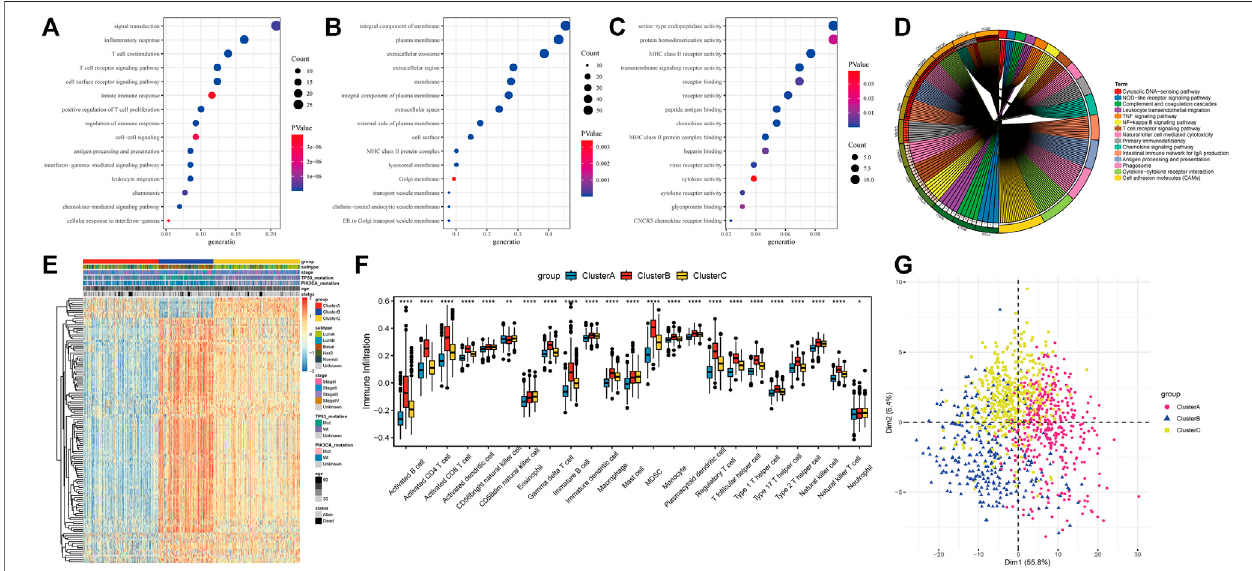
FIGURE 4 | Differentially expressed genes (DEGs) identi fi cation and functional analysis among tumor subtypes. (A) Biological process(BP) for DEGs; (B) Cellular component(CC) for DEGs; (C) Molecular functions(MF) for DEGs; (D) The top 15 enriched KEGG pathway of DEGs; (E) Heatmap of differentially expressed gene; (F) Difference of immune cell in fi ltration in three subtypes; (G) PCA analysis of expression pro fi le.